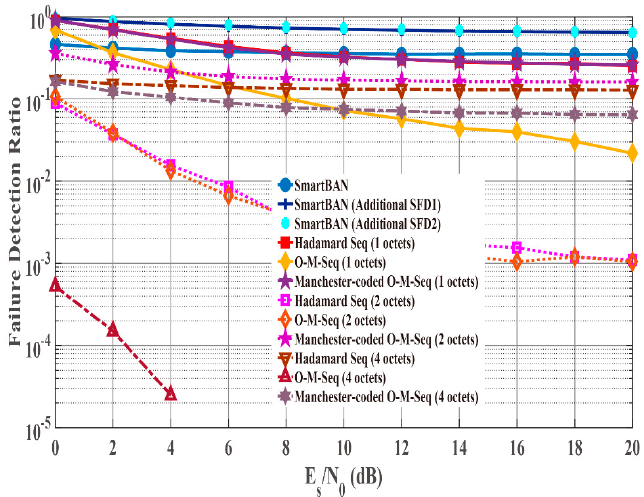
Sensors 2018 , 18 , x FOR PEER REVIEW Figure 9. Failure detection ratio under IEEE model CM3 as function of 𝐸 (cid:3046) /𝑁 (cid:2868) ( 𝐾 factor = 4.5). Figure 9. Failure detection ratio under IEEE model CM3 as function of E s / N 0 ( K factor = 4.5 ). Figure 9. Failure detection ratio under IEEE model CM3 as function of 𝐸 (cid:3046) /𝑁 (cid:2868) ( 𝐾 factor = 4.5).